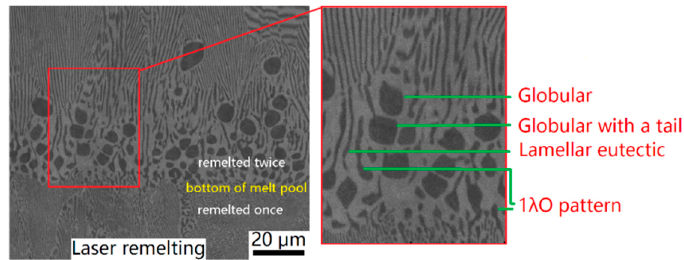
Figure 1. Backscattered electron images of anomalous eutectic morphologies at the bottom of melt pool after laser remelting Ni-30wt.%Sn powders twice, and its enlarged view of typical morphologies of anomalous α -Ni phase.